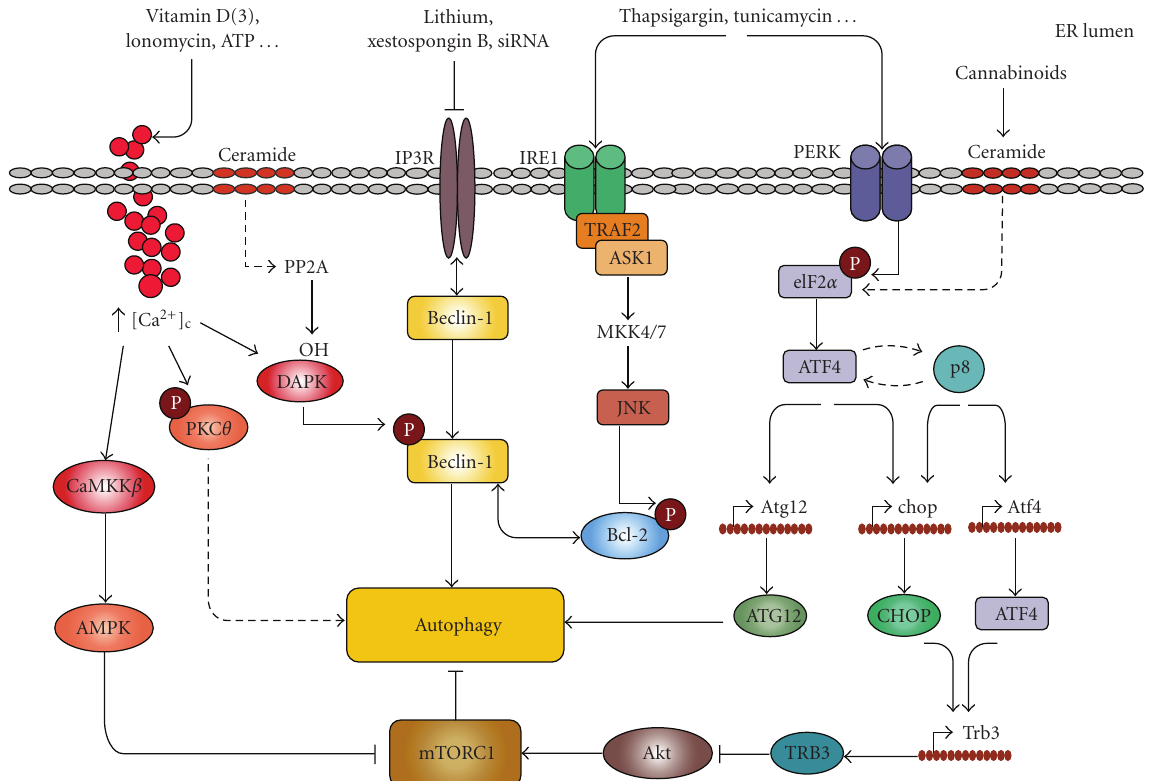
Figure 2: Mechanisms connecting ER stress and autophagy. Di ff erent ER stresses lead to autophagy activation. Ca 2+ release from the ER can stimulate di ff erent kinases that regulate autophagy. CaCMKK β phosphorylates and activates AMPK which leads to mTORC1 inhibition; DAPK phosphorylates Beclin-1 promoting its dissociation from Bcl-2; PKC θ activation may also promote autophagy independently of mTORC1. Inositol 1,4,5-trisphosphate receptor (IP3R) interacts with Beclin-1. Pharmacological inhibition of IP3R may lead to autophagy in a Ca 2+ -independent manner by stimulating its dissociation from Beclin-1. The IRE1 arm of ER stress leads to JNK activation and increased phosphorylation of Bcl-2 which promotes its dissociation from Beclin-1. Increased phosphorylation of eIF2 α in response to di ff erent ER stress stimuli can lead to autophagy through ATF4-dependent increased expression of Atg12. Alternatively, ATF4 and the stress-regulated protein p8 promote the up-regulation of the pseudokinase TRB3 which leads to inhibition of the Akt/mTORC1 axis to stimulate